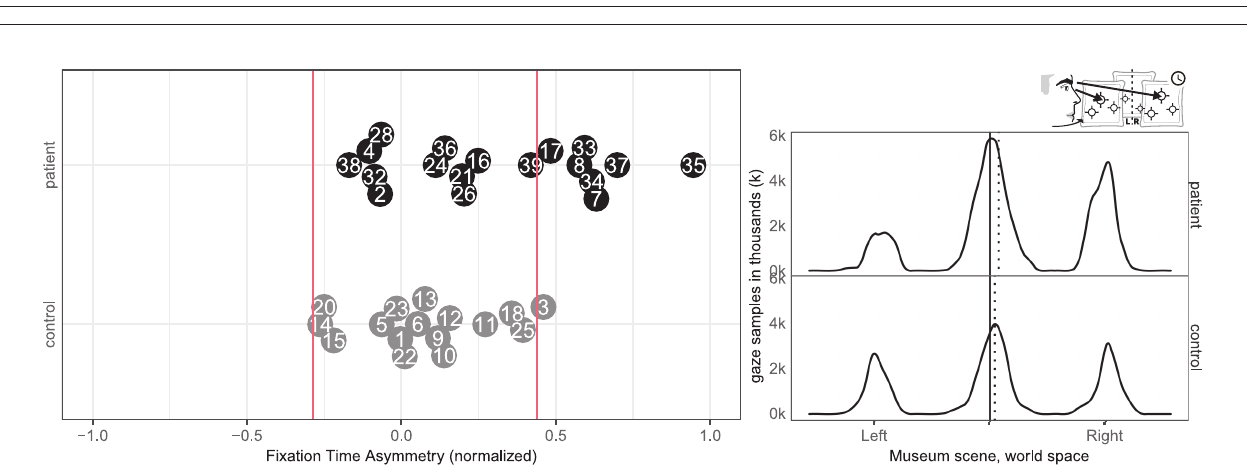
FIGURE 7 | Eye orientation left/right. (Left) Individual time spent rotating eye balls left and right in patient (black, top) and control (gray, bottom) with normative threshold cut-offs (red lines). (Right) Spatial distribution of patient and control eye ball orientation with true (solid) midline and group median (dotted).